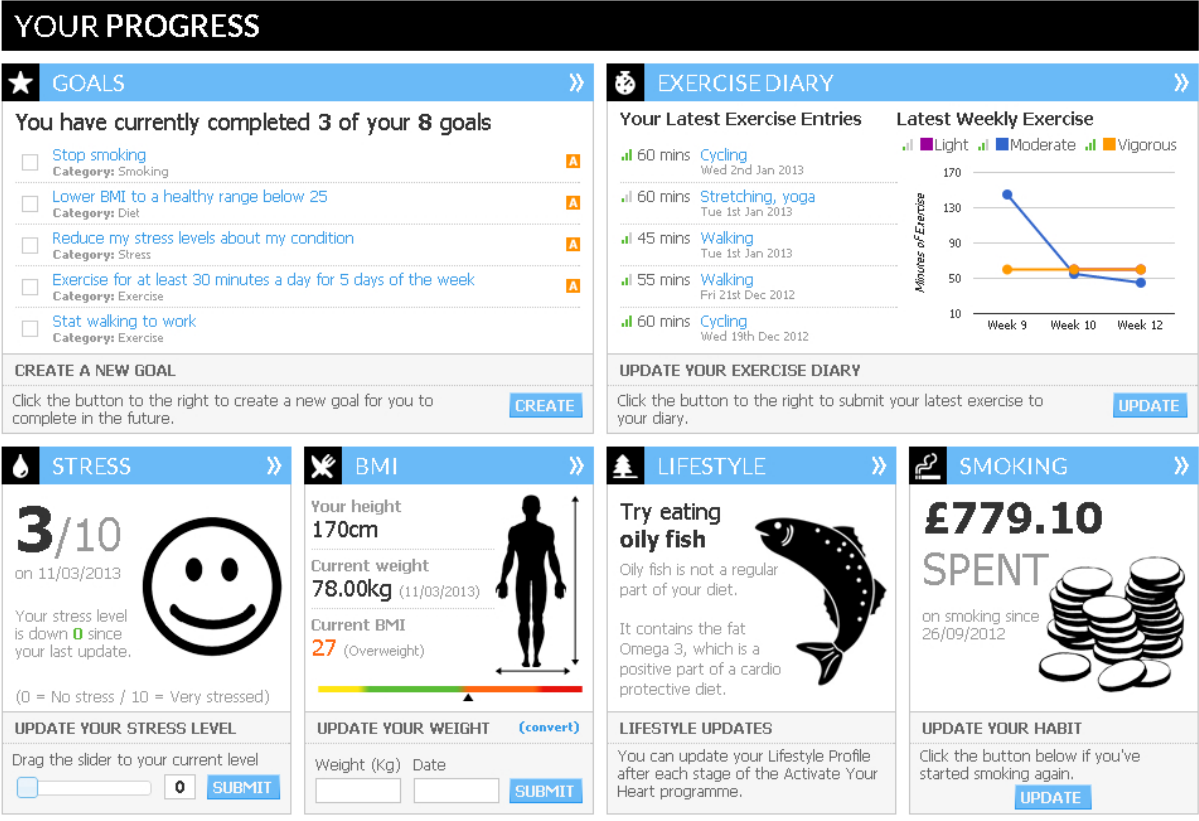
Figure 1. Program goal